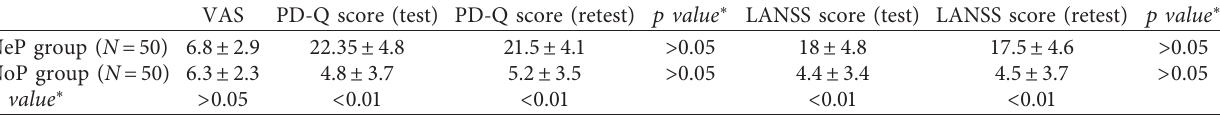
Table 2: VAS score, LANSS score (test/retest), and PD-Q score (test/retest) according to pain reference